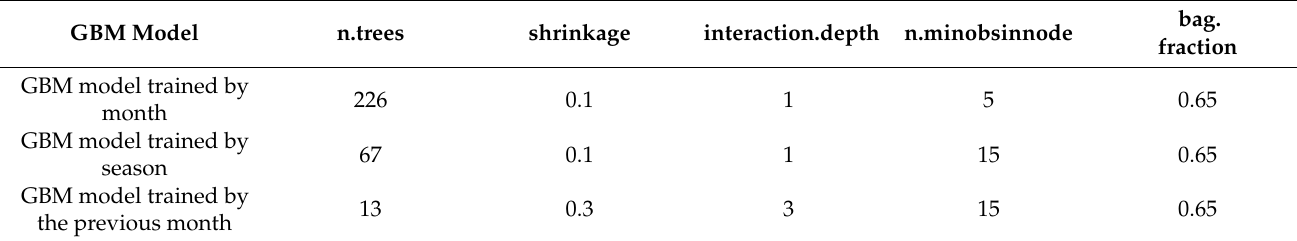
Table 5. Hyperparameters of the GBM model.